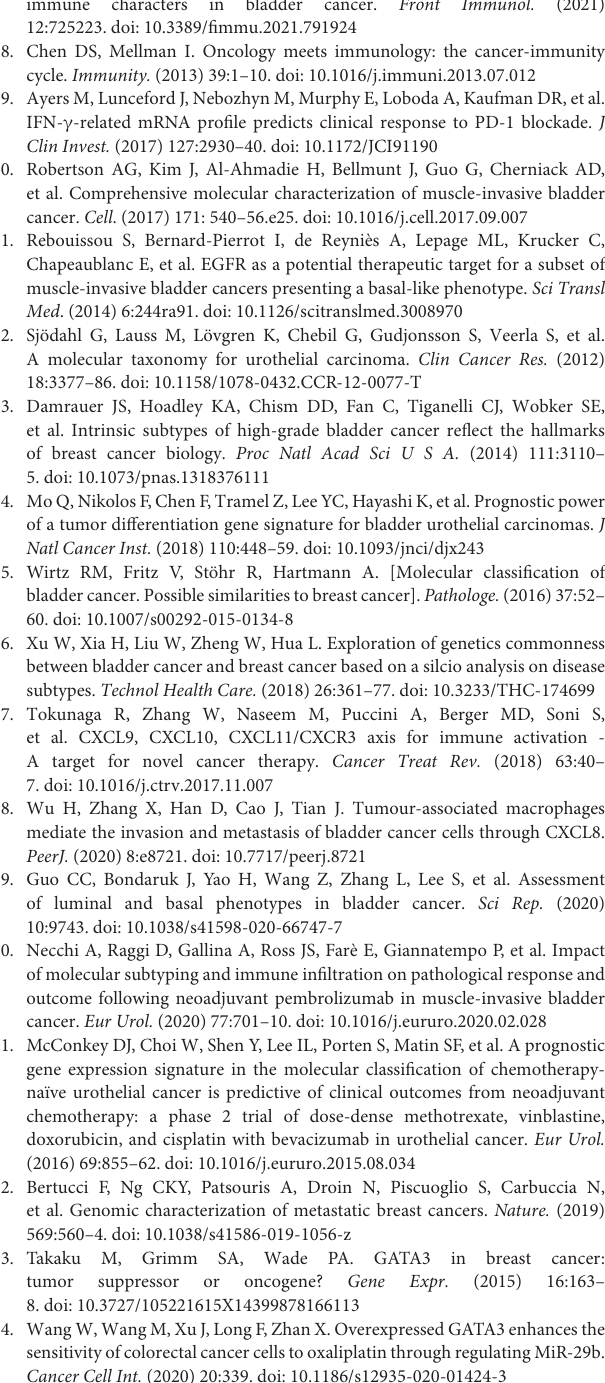
Supplementary Figure 1 | (A) The workflow of this study. (B) Single-cell analysis of GATA3 expression in tumor and normal tissues. (C) Correlations between GATA3 and molecular subtypes with seven different subtyping systems in GSE32894. (D) ROC analysis on the prediction accuracy of GATA3 for molecular subtypes with different systems in GSE32894. (E,F) The same analytical methods as those in Supplementary Figures 1C,D used in